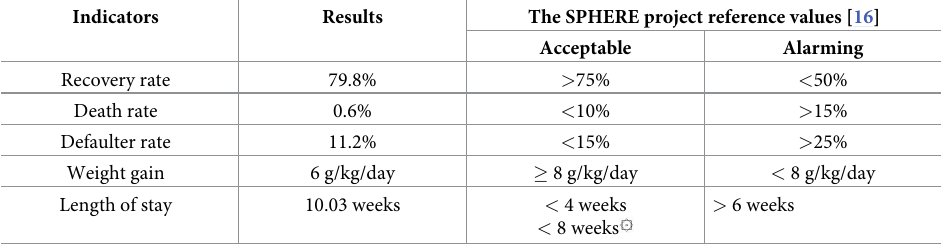
Unlike the sphere standard which set to be 4–6 weeks, the Ethiopian national protocol for management of SAM indicated for children to stay under OTP for a maximum of eight